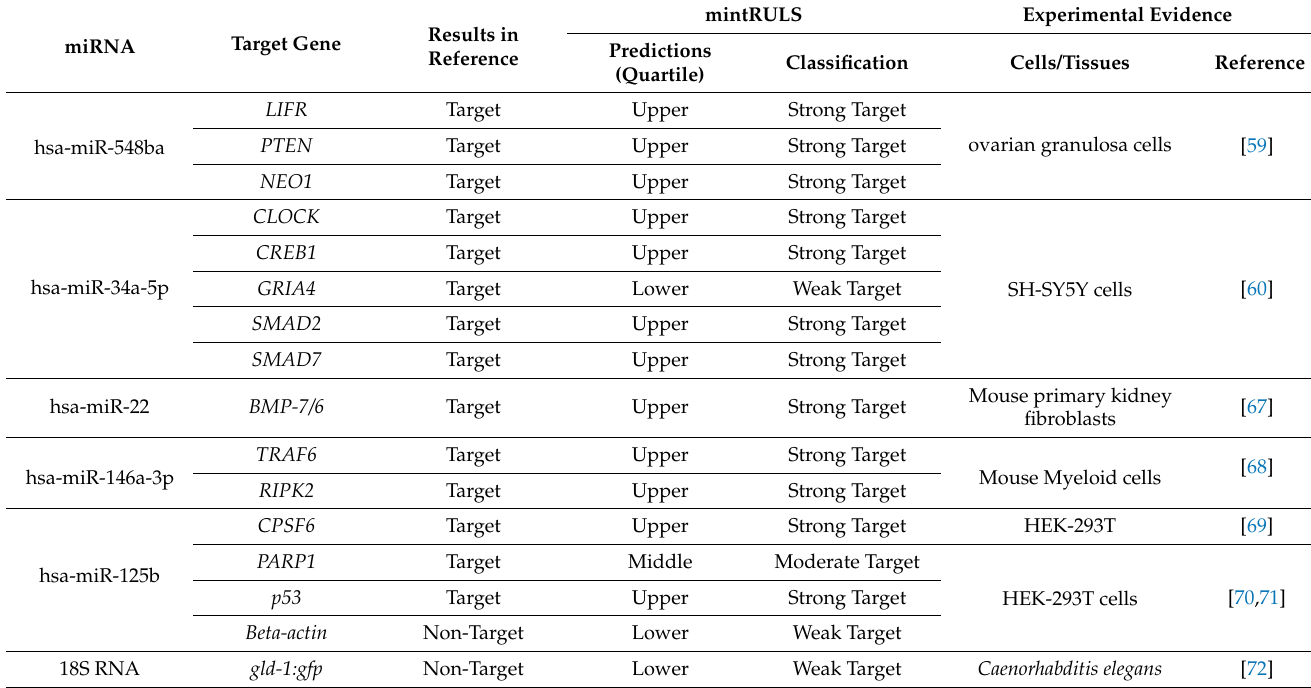
Table 2. Predicted miRNA-miTS interactions using mintRULS and validation using experimental data in human. Strong Target: Upper quartile (>75th percentile), Moderate Target: Middle quartile (in between 25th and 75th percentile), and Weak Target: Lower quartile (<25th percentile).